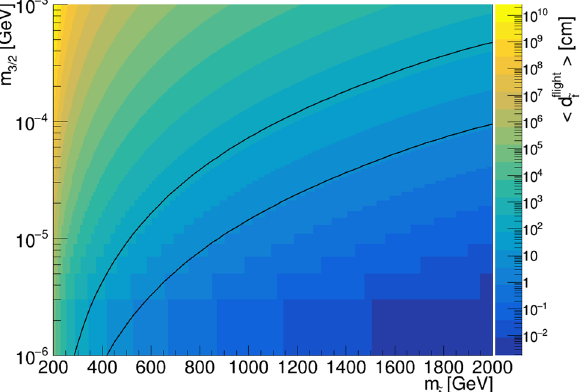
Fig. 45 Mean flight distance of the stop in the laboratory frame as a function of the stop and the gravitino masses. The black lines represent the geometrical limits of the tracker volume, i.e., 4 cm and 100